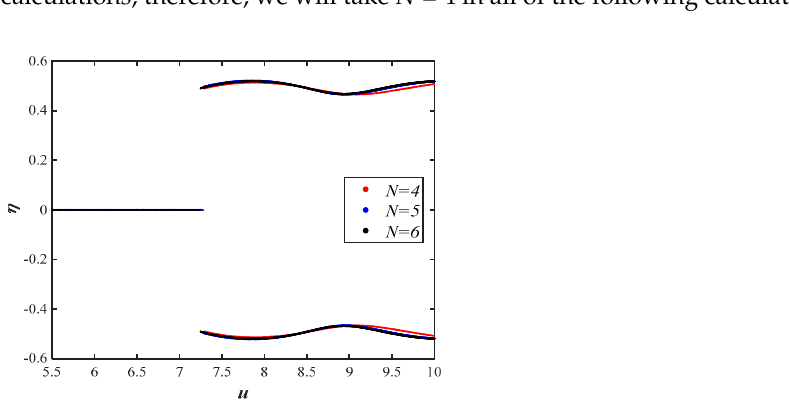
( c ) Figure 5. Dynamic response of the pipe with dry friction when u = 7.5: ( a ) Time history curve of the tip − end of the pipe; ( b ) oscillation shapes of the pipe; ( c ) phase portrait of the tip − end of the pipe. 5.2. Effect of Installation Position ξ d Next, we will discuss the effect of the installation position of the dry friction restraint on the stability of the pipe system. The location parameter ξ d is set to be 0.3, 0.5, 0.7, and 0.9. The other key parameters are chosen to be: α = 0.001, β = 0.213, and f n = 0.5. The ob- tained bifurcation diagrams are shown in Figure 6. When the installation position of the dry friction restraint is ξ d = 0.3, it can be seen that the system is subjected to flutter insta- bility at u = 7.72. As the flow velocity is in the range of [7.73,7.87], compared with the pipe without dry friction, the displacement amplitude at the free end of the pipe is significantly